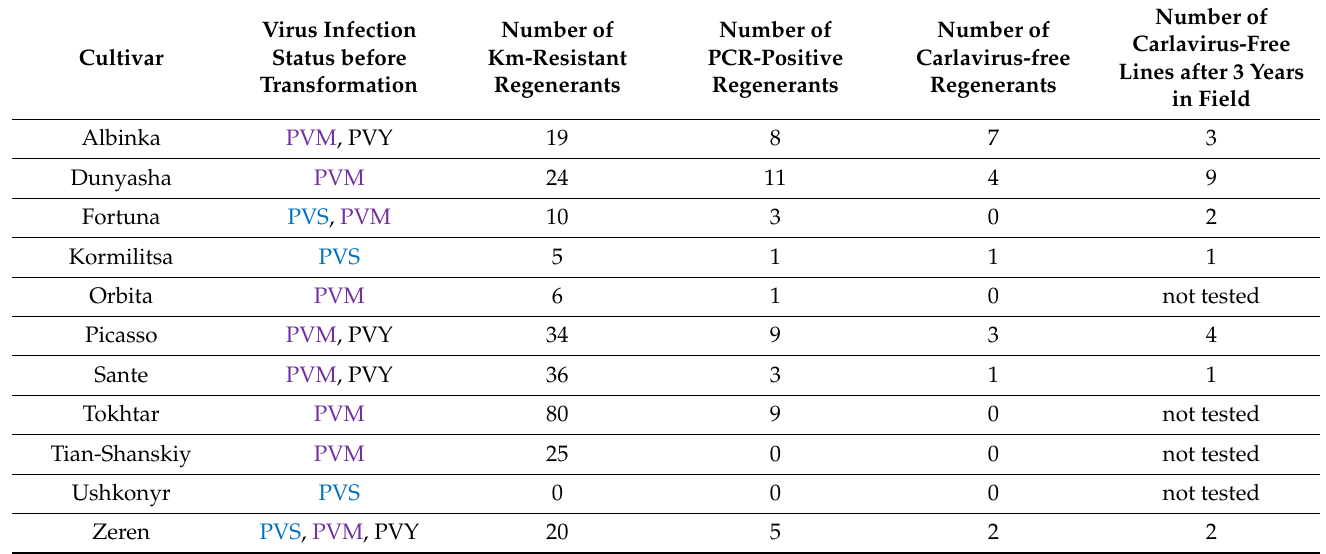
Table 1. Initial infection status of potato cultivars and carlavirus resistance of PCR-positive